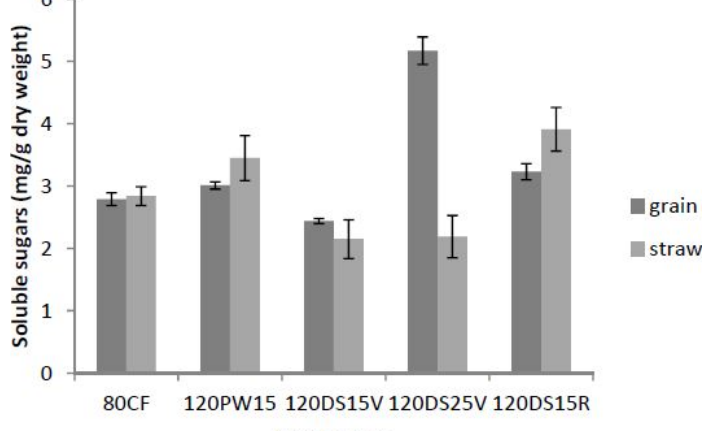
Figure 2. Impact of potassium fertilization on soluble sugars in grain and straw under water stress at different growth stages of rice N = 12. Bars represent standard error of differences between